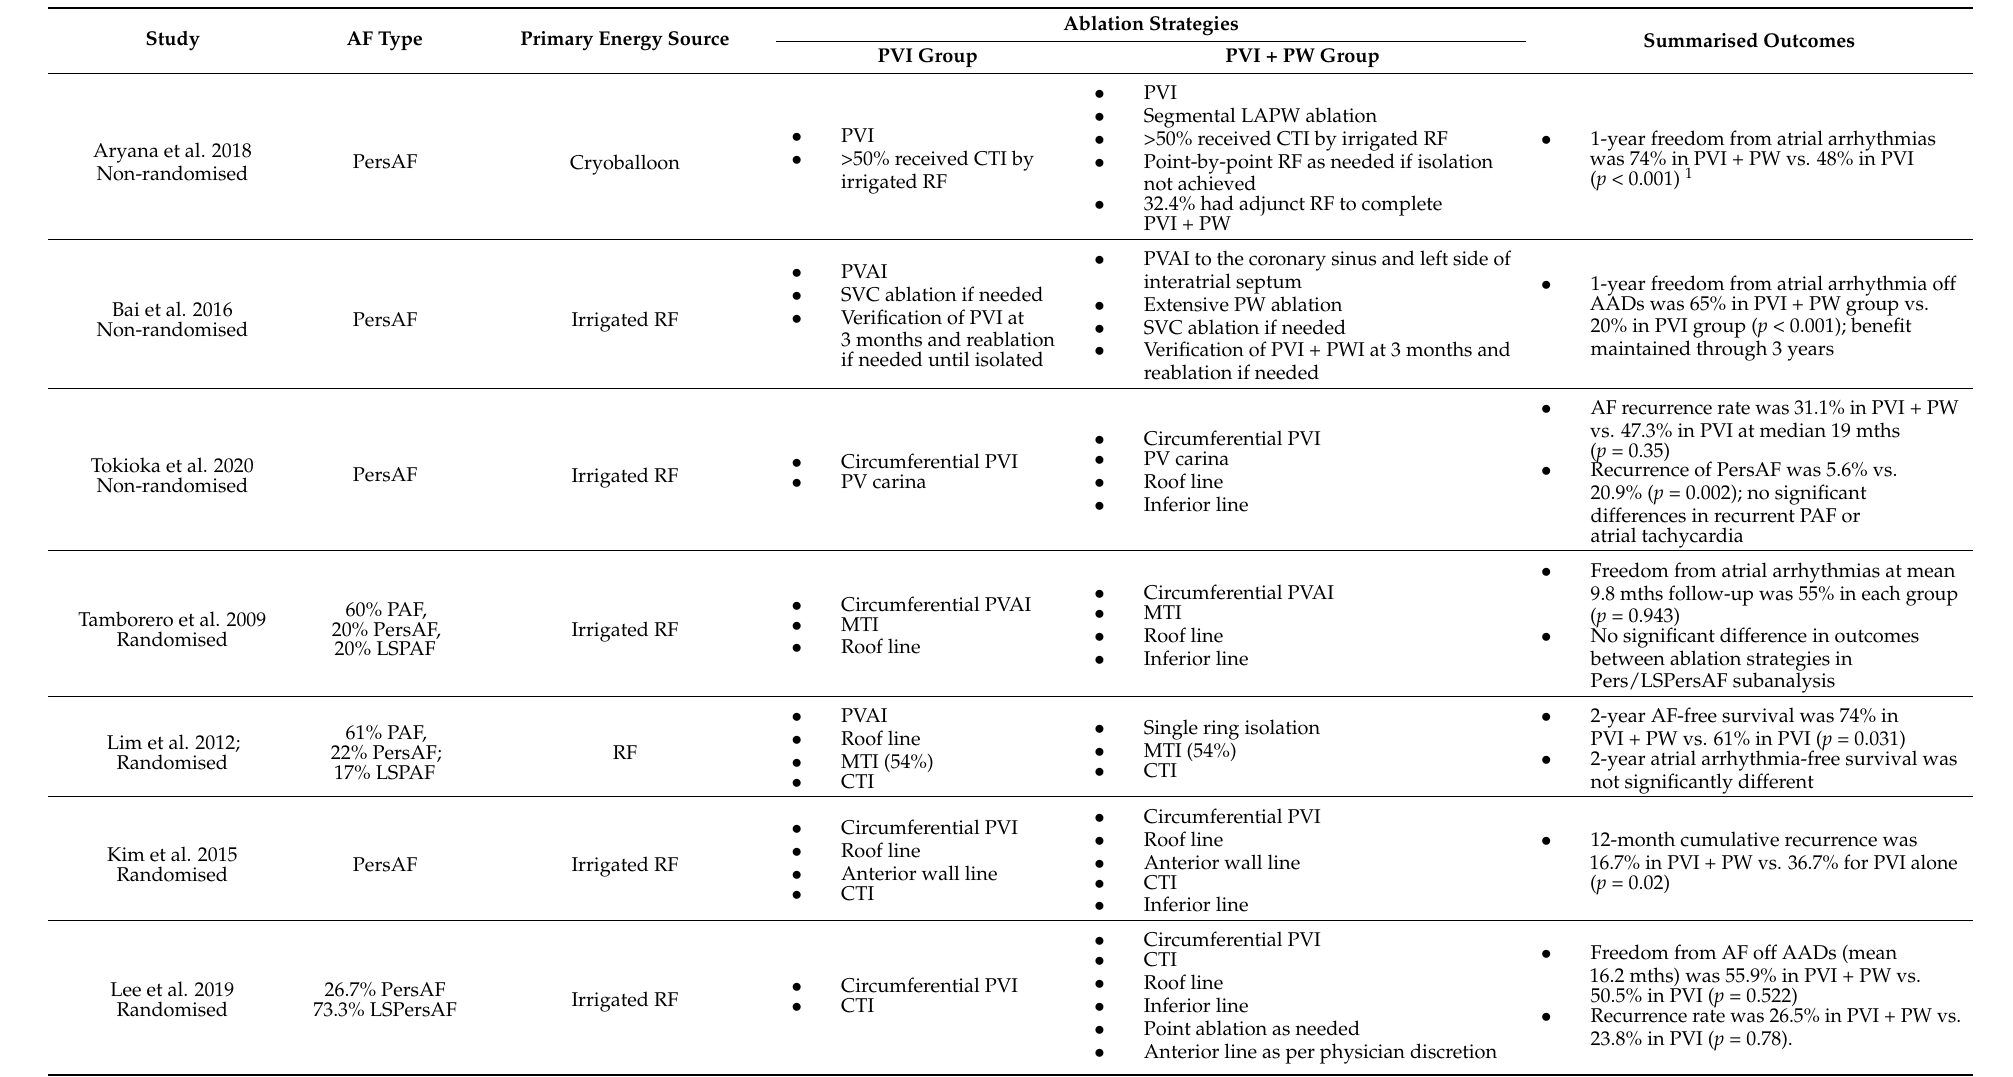
Table 1. Summary of select studies evaluating addition of posterior wall isolation to pulmonary vein